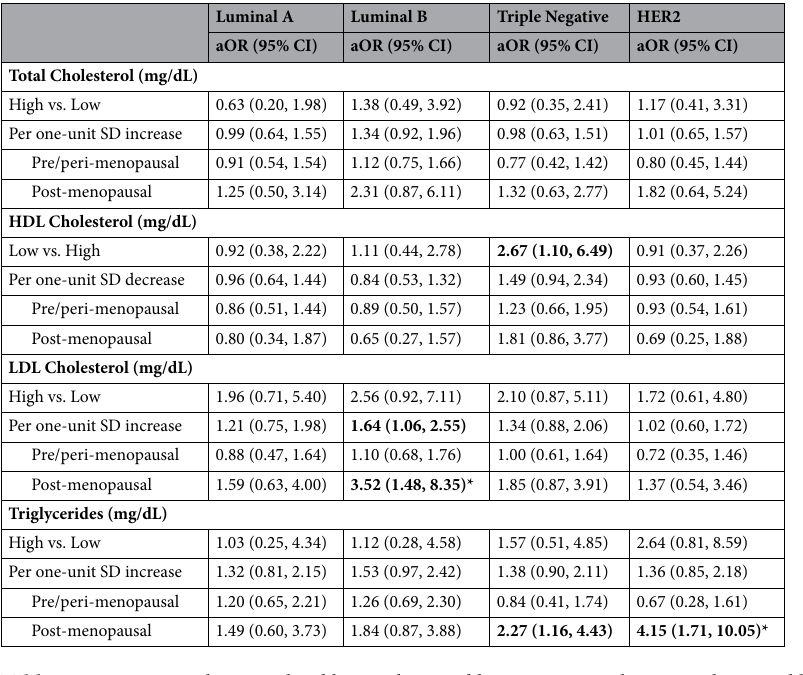
Table 4. Associations between lipid biomarkers and breast cancer subtype. Multinomial logistic regression models for the odds of having each cancer subtype, compared to no cancer, by lipid profile biomarkers. ORs per one-unit SD were modeled as a one-unit increase/decrease in SD of the lipid profile variable from its mean-centered value. Bolded values indicate significance at p <.05. * indicates significance at p <.0125. High total cholesterol defined as >200 mg/dL; low HDL defined as <50 mg/dL; high LDL defined as >100 mg/dL; high triglycerides defined as >150 mg/dL. Models were adjusted for age and clinical characteristics: BMI, age at menarche, number of pregnancies, number of births, hypertension at enrollment, and menopausal status. aOR adjusted odds ratio, CI confidence interval, SD standard